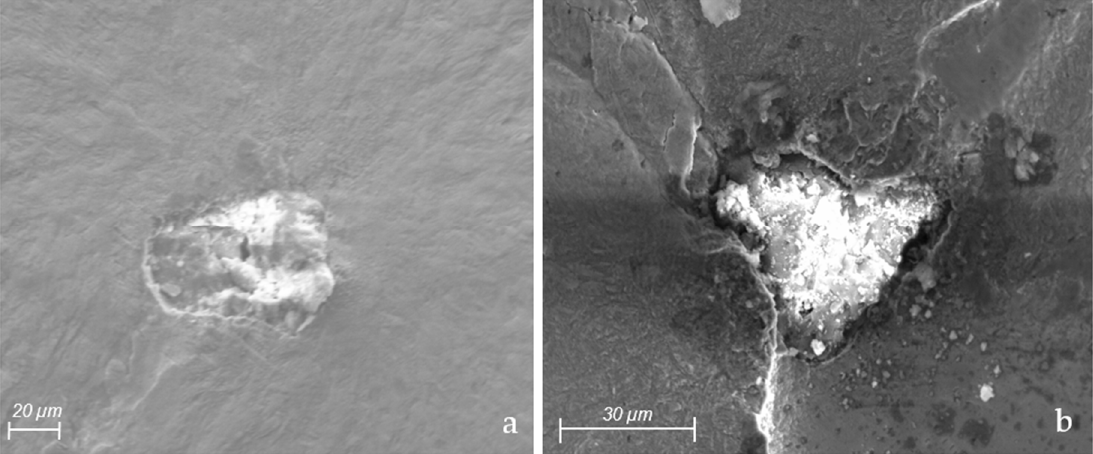
Figure 6. Critical inclusions. ( a , b ) with angular shape of TMT specimens.